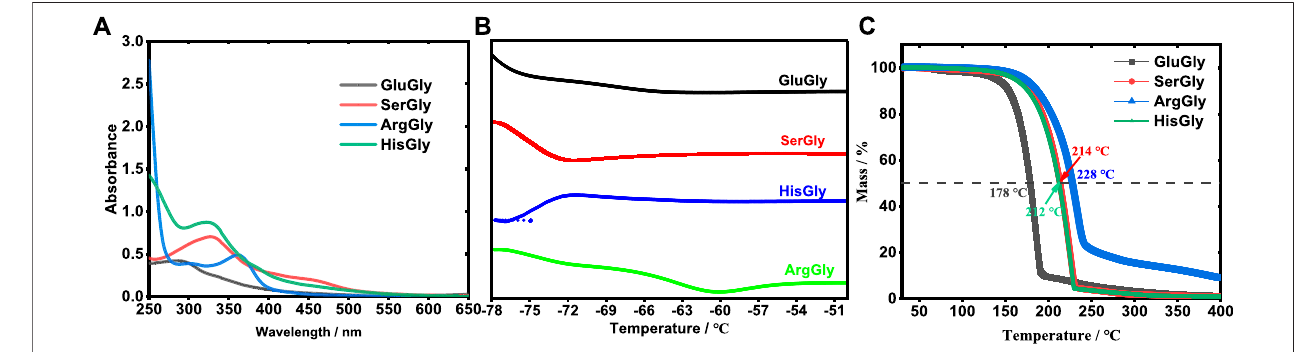
FIGURE 1 | (A) UV curve of NADESs. (B) DSC curve of NADESs. (C) TG curve of NADESs.